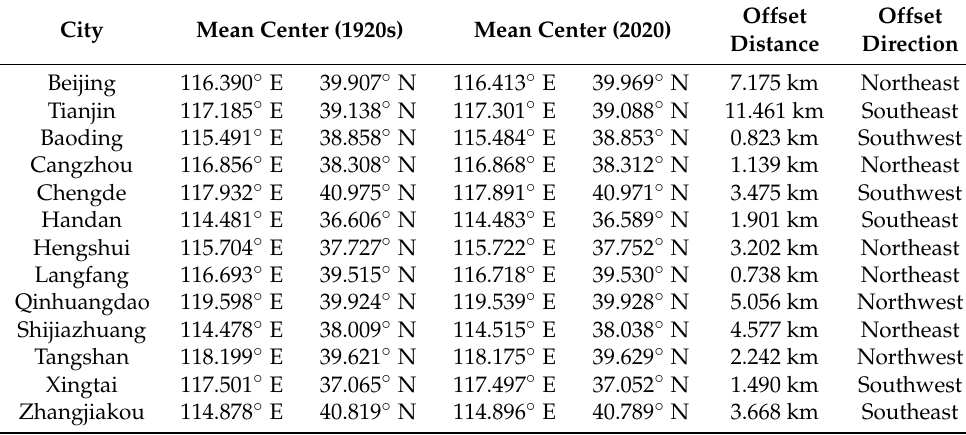
Table 3. Shift of the mean center of the built-up